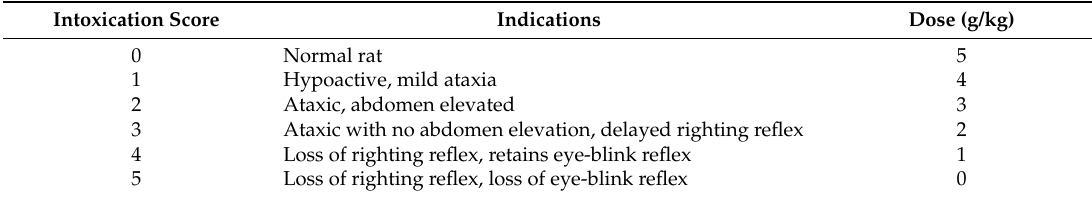
Table 2. Scale of behavioral